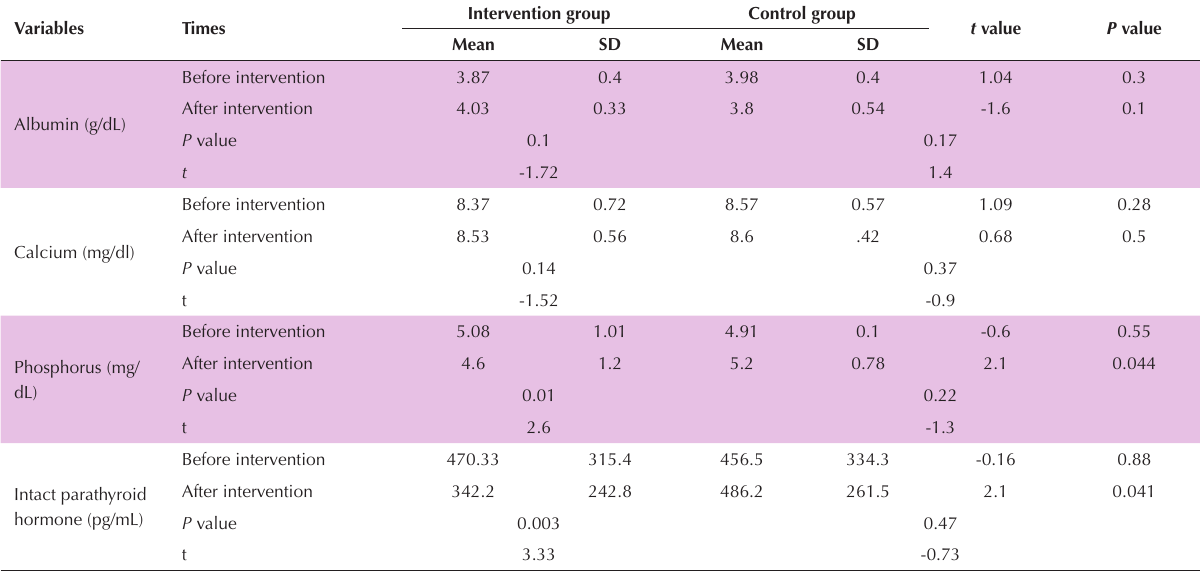
Age Average age (y) The number of months of treatment with dialysis